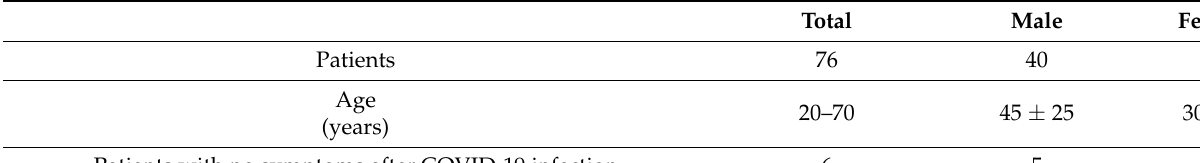
Table 1. Percentage of post-COVID-19 signs and symptoms according to sex.